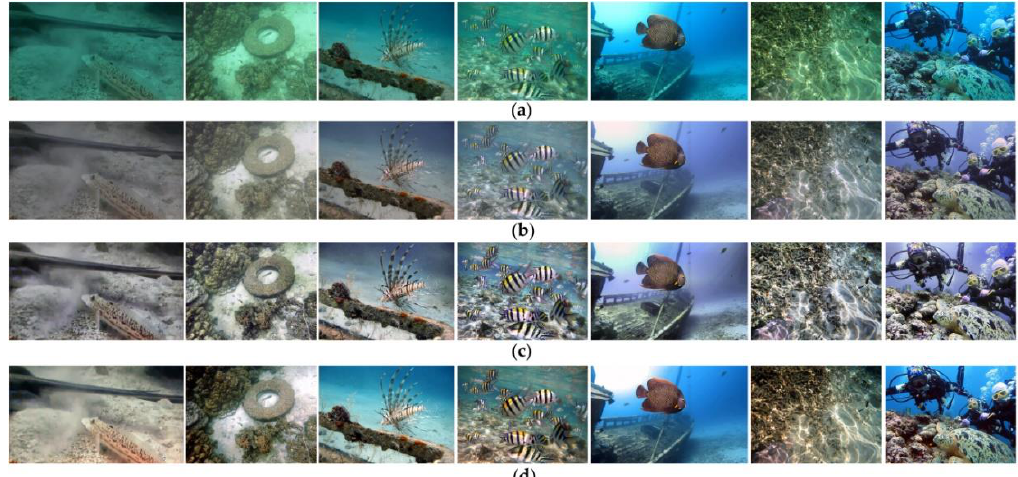
Figure 16. Enhanced underwater images obtained by combining the proposed color correction method with CLAHE: ( a ) Raw underwater images, ( b ) Results of the proposed color correction method, ( c ) Results by applying CLAHE to images shown in ( b ), ( d ) Reference images. Raw and reference images are provided with the UIEB dataset [8].